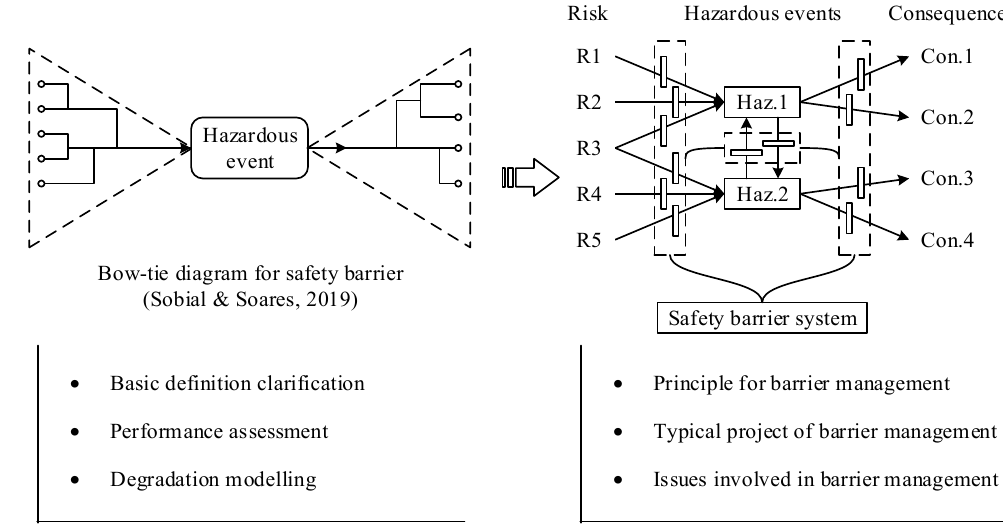
Figure 12. Studies overview of safety barrier issues.